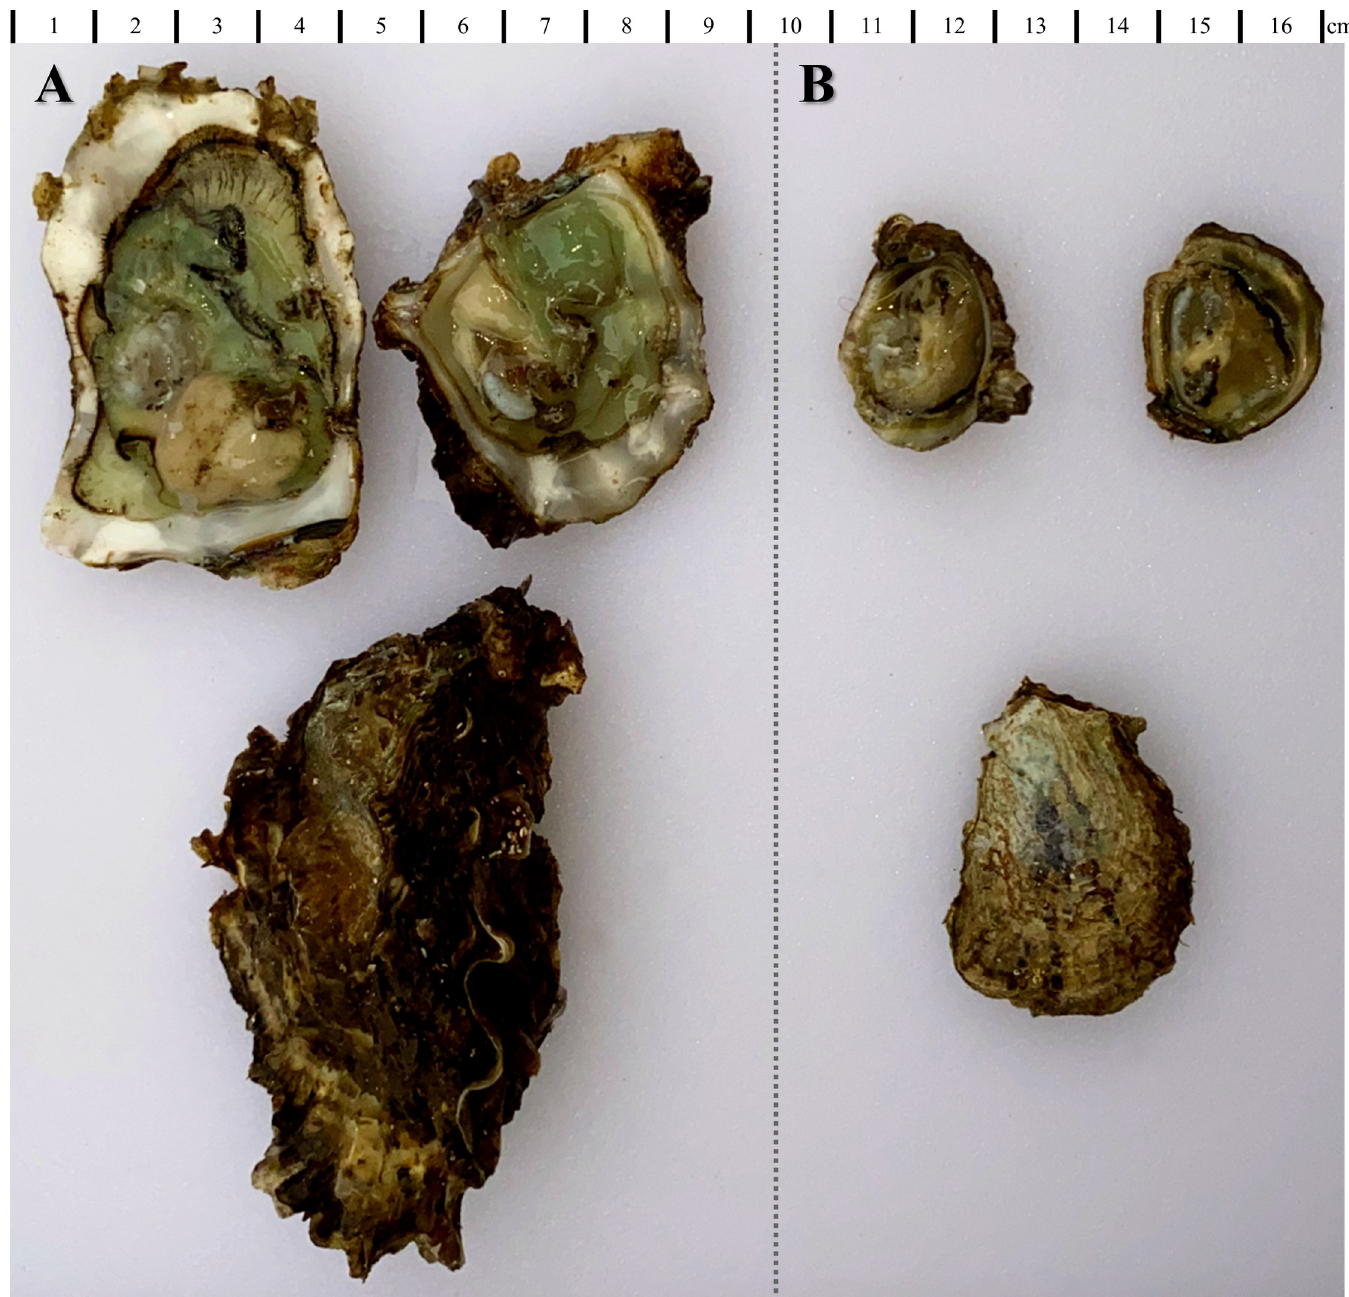
Fig 1. Native and non-native oysters. Photos of M . gigas (A) and O . lurida (B) shucked (top row) and intact (bottom row), collected from San Diego Bay, CA in